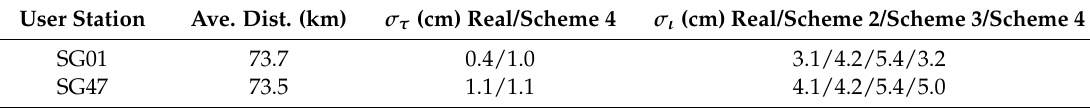
Table 3. Interpolated atmospheric correction accuracy with long inter-station distance